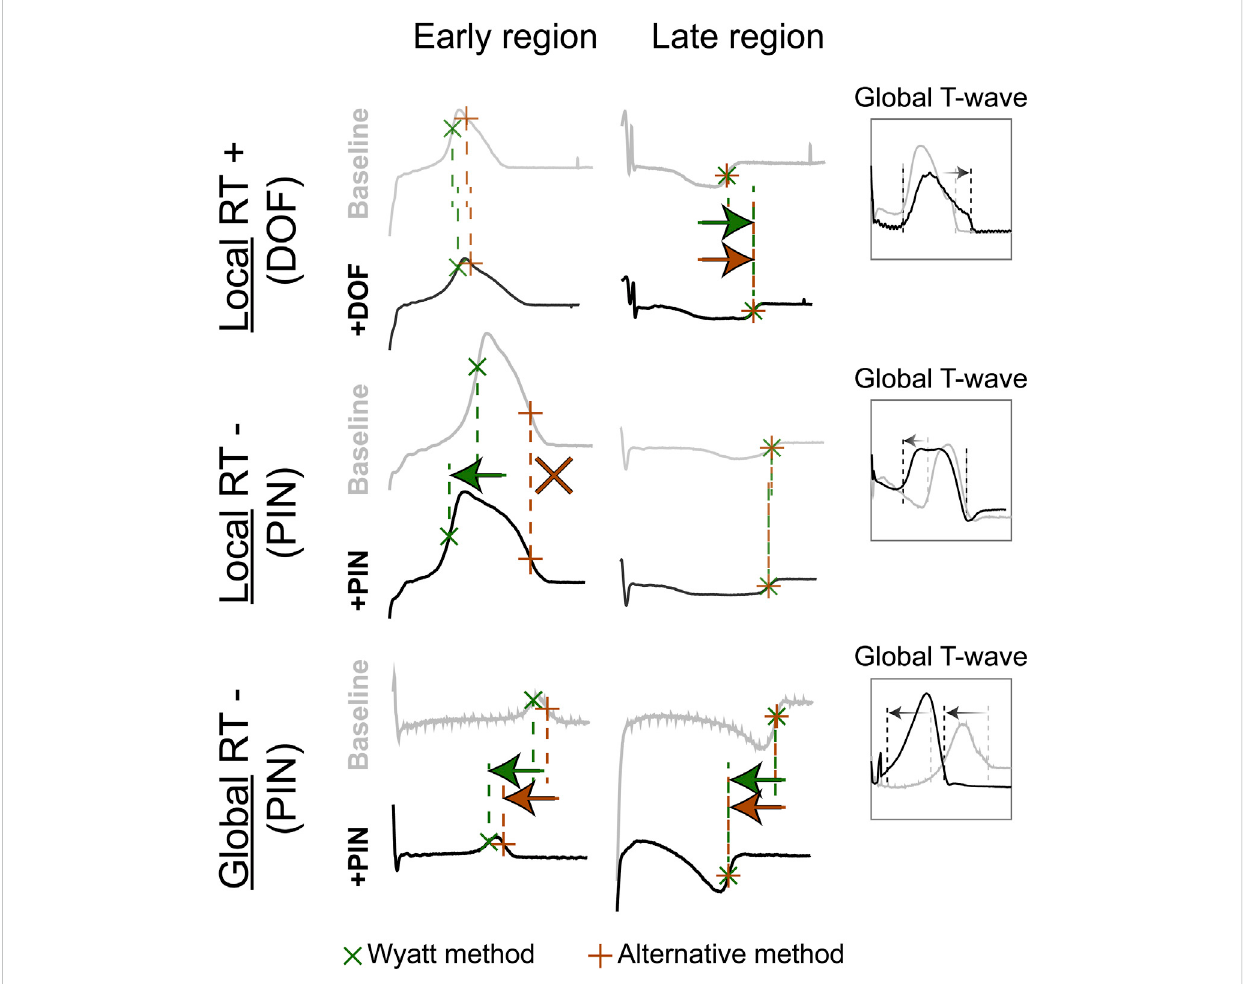
FIGURE 4 The effect of repolarization-altering drugs on T-wave morphology and RT. Top: repolarization-prolonging dofetilide (DOF) is infused in the late- repolarizing area, causing local RT-prolongation, as captured by both theWyatt and alternative methods, and the “ Global T-wave ” (root-mean-square of all epicardial UEGs). Middle: repolarization-shortening pinacidil (PIN) is infused in the early-repolarizing area, causing local RT-shortening, captured by the Wyatt method, but not the alternative method. Bottom: global infusion of pinacidil in the entire heart causes a leftward shift of all T-waves (see global T-wave), which is captured by both